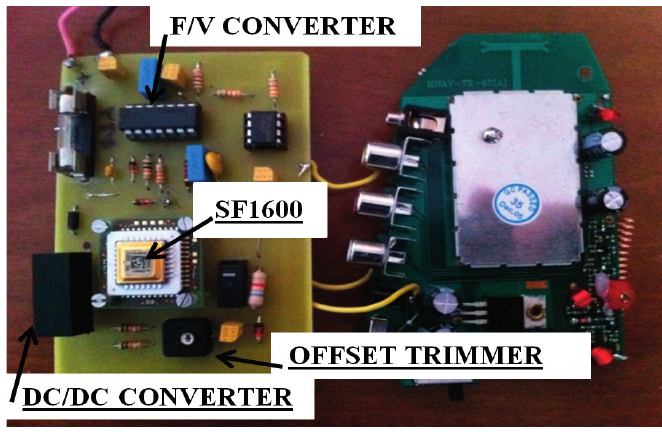
Figure 3. Prototype of the transmitter board.